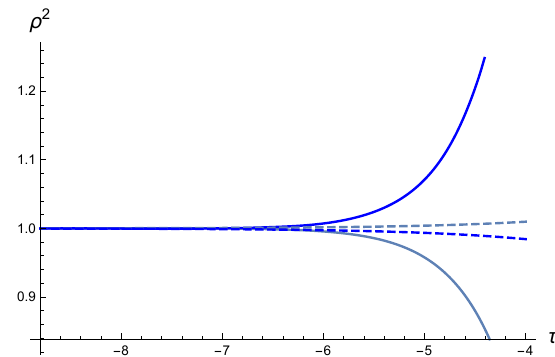
Figure 8. The solution for (cid:26) 2 ( (cid:28) ) for the smooth pro(cid:12)le of the form (4.8). These have (cid:14)t = 1 : 1 and the adiabatic condition is imposed at T = (cid:0) 8 : 8. The grey lines are for ! 0 = 1 ; ! 1 = 0 : 5 while the blue lines are for ! 0 = 1 ; ! 1 = 1 : 5. The dashed lines are the adiabatic solutions, while the solid lines are the exact